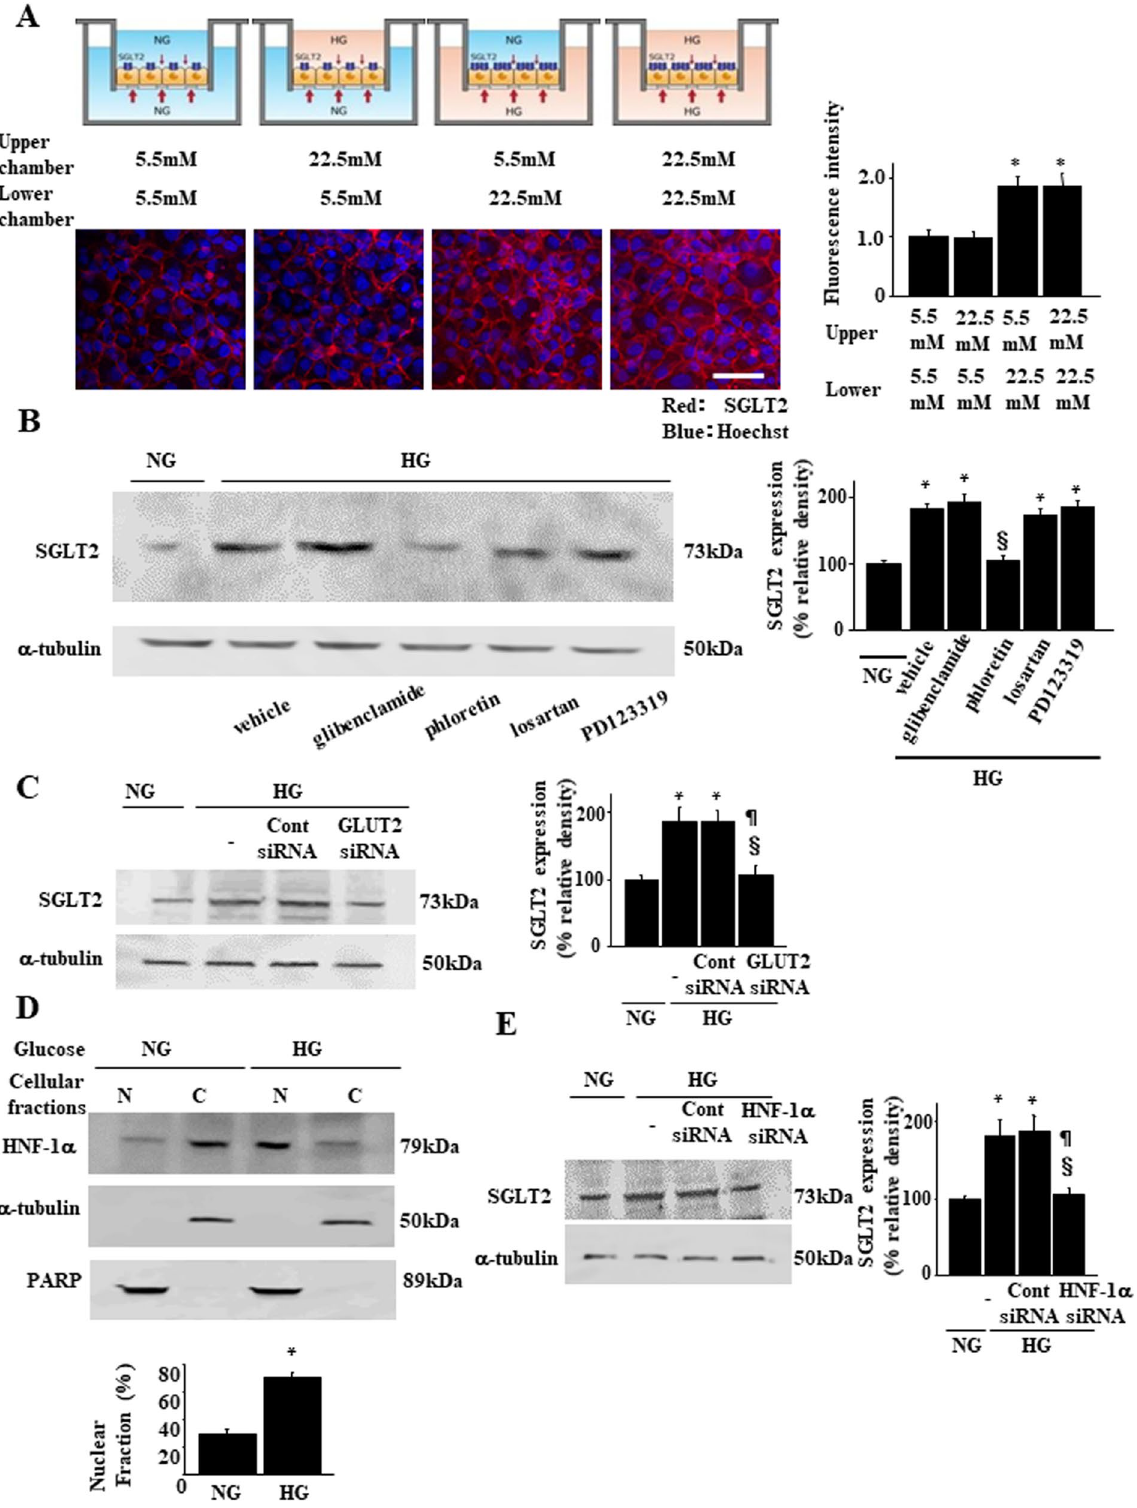
Figure 3. Effect of high glucose on SGLT2 expression in a two-chamber culture system. ( A ) Confluent growth- arrested cell monolayers were stimulated on the apical or basolateral side for up to 24 h, as described in the Methods section. Representative SGLT2 fluorescence of the four groups of culture conditions is shown. The bar graph represents the fluorescence intensity of each group ( * P < 0.05 vs. the group with 5.5 mM D-glucose in the lower chamber and 5.5 mM D-glucose in the upper chamber, n = 4 independent experiments. Scale